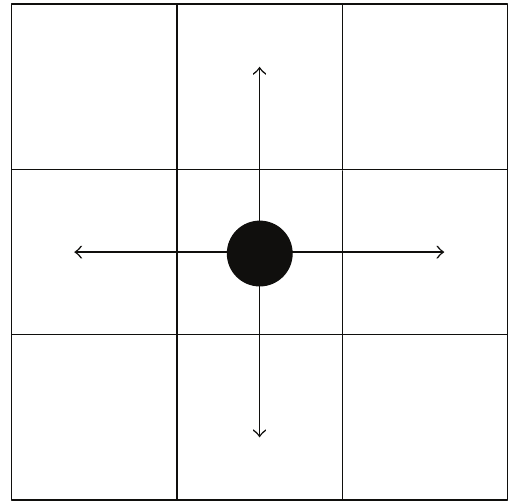
Figure 5: Von Neumann motion rule.